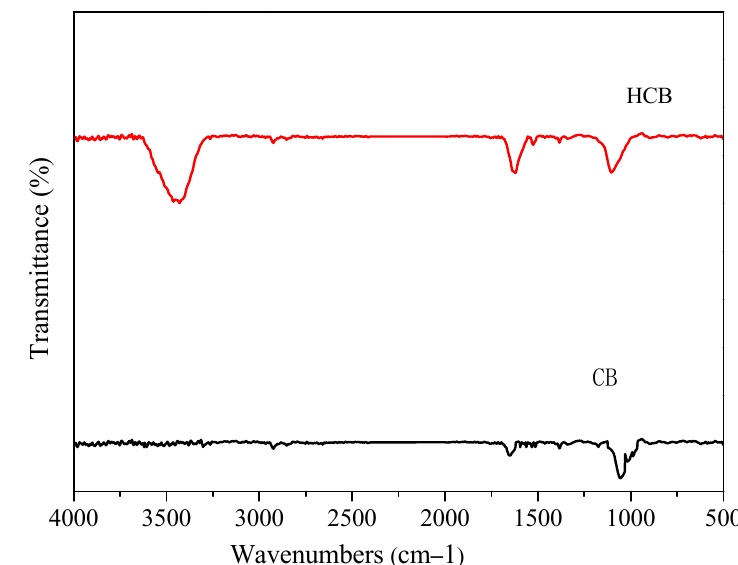
Figure 4. The infrared spectra of CB and HCB.